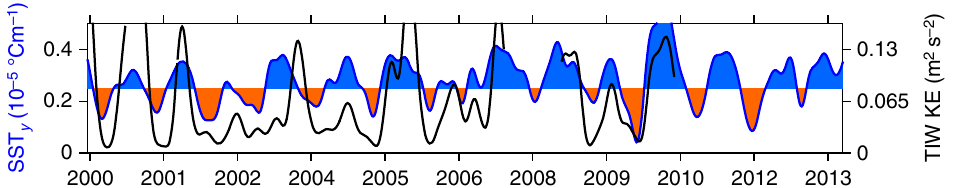
Figure 3 | Separating TIW and non-TIW periods with meridional SST gradient. The blue curve denotes the meridional SST gradient (SST y ). The TIW (non-TIW) periods are depicted with blue (red) shading. The black curve denotes the 140-day low-pass-filtered TIW KE. The correlation coefficient between the filtered TIW KE and the SST y over 2000–2010 is r ¼ 0.47, with P o 0.001 and 95% CI ¼ (0.44, 0.49).